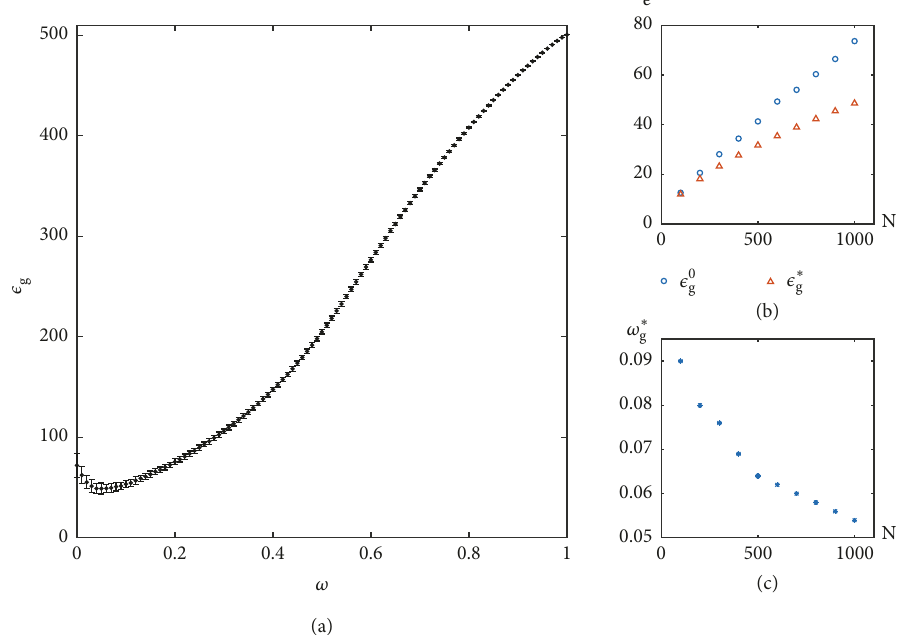
Figure 3: The numerical simulation of average ‘energy’ of all agents, 𝑁 = 1000 ; the result is averaged over 100 realizations. (a) The average ‘energy’ of all agents, as a function of 𝜔 ; (b) for 𝑁 = 100,200,300,. . ., 1000 , the average ‘energy’ at 𝜔 = 0 is denoted by 𝜖 0 𝑔 and at the global optimal popularity weight 𝜔 ∗ 𝑔 is denoted by 𝜖 ∗ 𝑔 ; (c) the optimal weight 𝜔 ∗ 𝑔 versus 𝑁